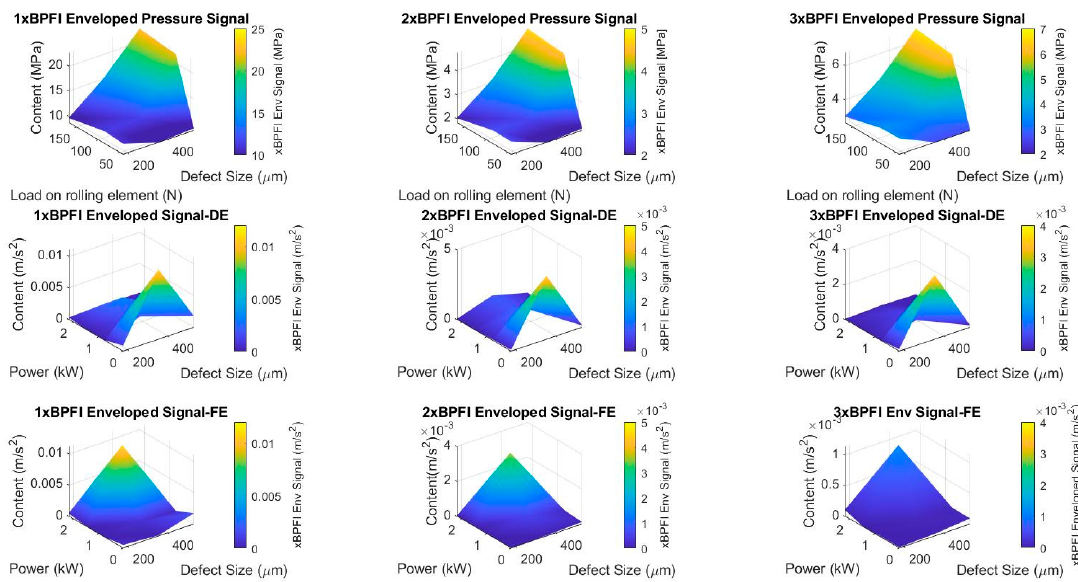
Figure 15. x BPFI contents for contact pressure, DE and FE enveloped signals.